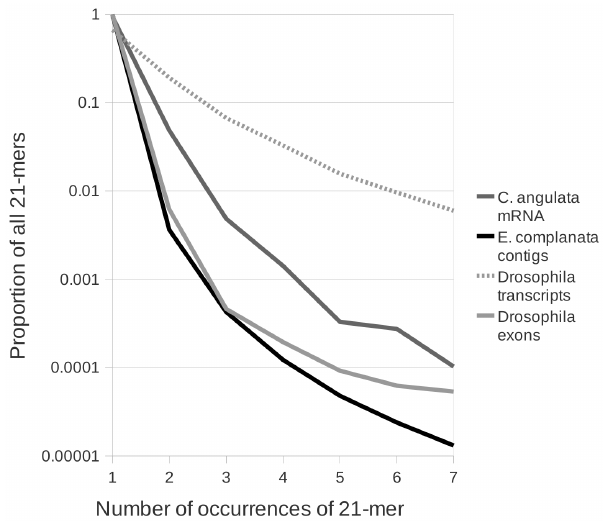
Figure 1. The proportion of unique sequence in the Elliptio complanata assembly and three other reference sequences. The total occurrences of all distinct 21-bp kmers was tabulated and the frequency of those occurring from one to seven times is shown on a log scale. The complete exome and transcriptome of Drosophila melano- gaster , downloaded from BioMart [17], serve as lower and upper bounds of the redundancy of 21-mers that would be expected to be recovered from shotgun transcriptomics of that species. mRNA of Crassostrea angulata (Portuguese oyster) downloaded from GenBank and clustered at 90% identity serves as the most closely-related reference for molluscs currently available.